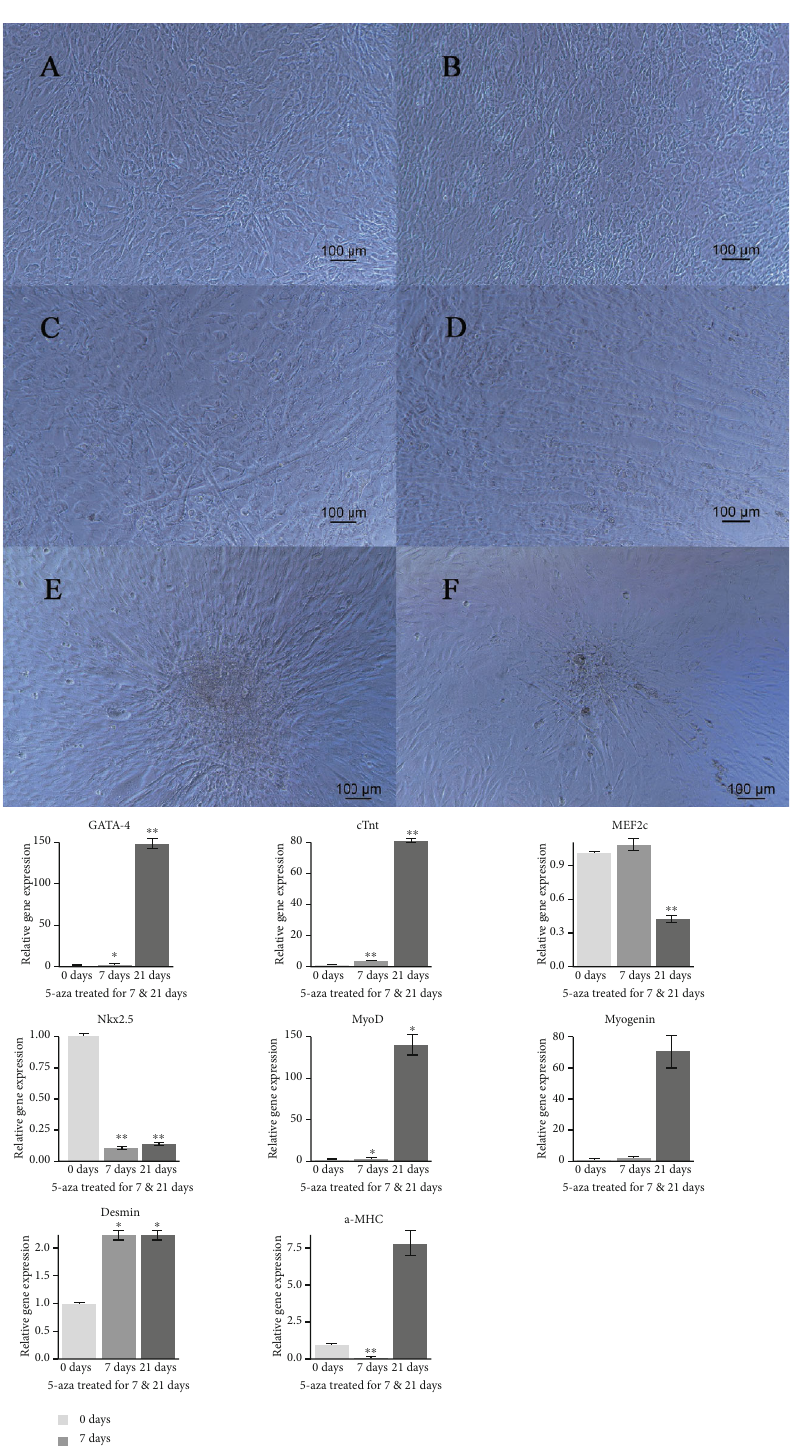
Figure 2: The morphology and characterization of mouse MSCs and the relative expression pro fi le of cardiomyogenic and myogenic marker genes. Up: 5-azacytidine induces C3H10T1/2 cells into di ff erentiated myocytes. (a) C3H10T1/2 cells. (b) C3H10T1/2 cells were treated with 20 μ M 5-azacytidine for 7 days, and cells were displayed in the same direction. (c and d) Myotube-like structure appeared after 5-azacytidine treating, then cells were changed into growth media and cultured for the next 21 days. (e and f) Di ff erentiated myocytes were picked with cell ring and cultured for additional two weeks. Myocyte-like cells could be subcloned and had abilities to form myotube-like structure. Down: the relative expression pro fi le of cardiomyogenic and myogenic marker genes: GATA-4 , cTnt , MEF2C , NKX-2.5 , MyoD , Myogenin , Desmin , and α -MHC were determined using real-time PCR at 0, 7, and 21 days after 5-azacytidine treatment ( ∗ P < 0 : 05 , ∗∗ P < 0 : 01